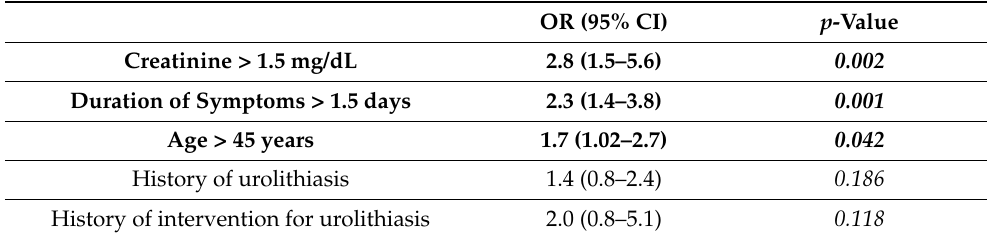
Table 4. Stone location and size according to age, creatinine level and duration of symptoms.